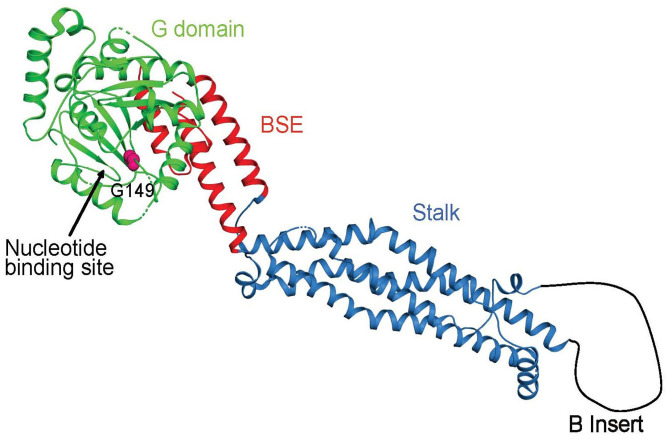
Crystal structure of DNM1L in ribbon representation (pdb code 4BEJ). The identified mutation site in the nucleotide-binding cleft is indicated.